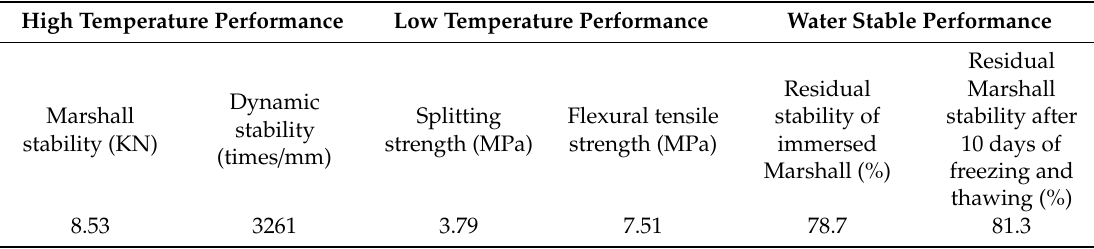
Table 2. Asphalt mixture road